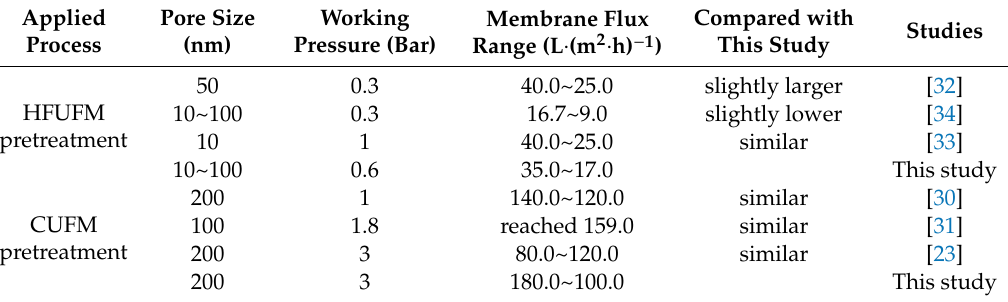
Table 3. Studies applied HFUFM or CUFM process to pretreating the biogas